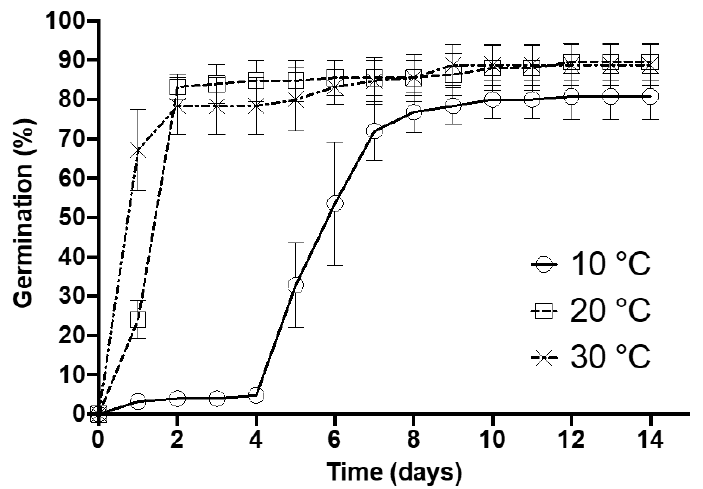
Figure 2. Cumulative germination of S. hispanica at 10, 20 and 30 ◦ C. Values are expressed as mean ± SD of five independent replicates. Statistical analysis was performed using Kruskal-Wallis ( p < 0.001) followed by a Dunn’s test multiple comparison test. Asterisks indicate significant differences between treatments (*** p < 0.001). Table 1. Final germination percent and median germination time (t 50 ) of seeds during imbibition at 10, 20, and 30 °C. Final germination is the percentage of seeds in which the germination process reaches the end; while median germination time (t 50 ) is the time to reach 50% of final germination. Temperature Final Germination (%)